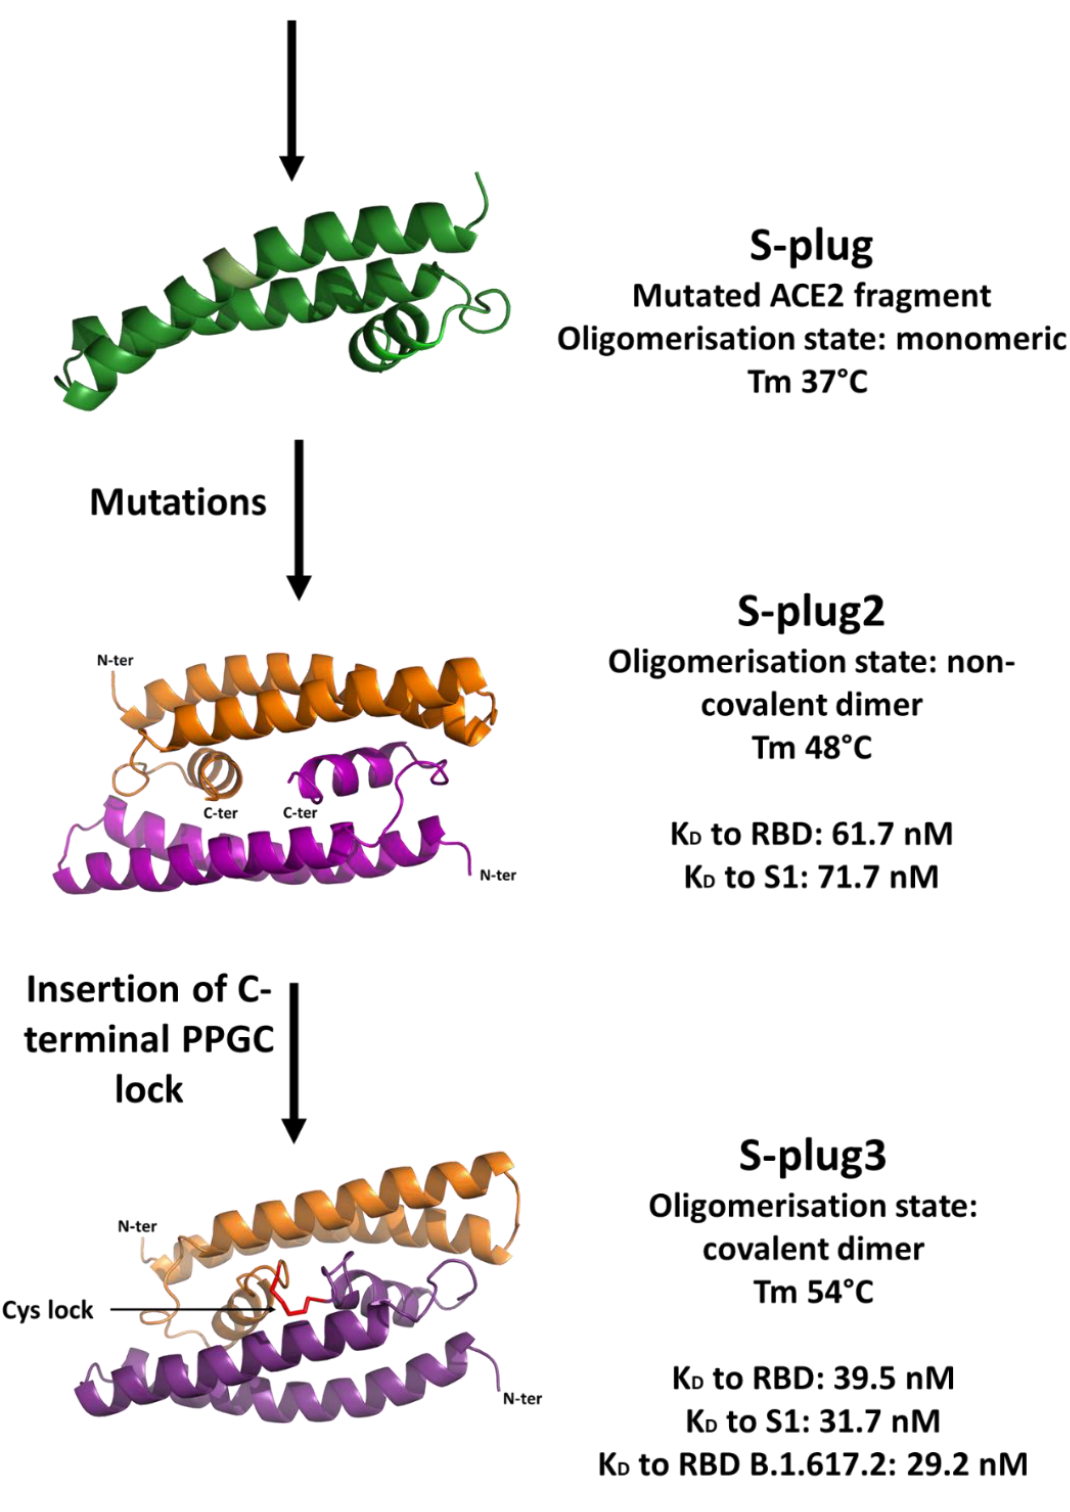
Figure 6. A sketch of the S-plugs’ design strategy with a summary of their thermal stabilities and binding affinities to the spike RBD and S1 domain.